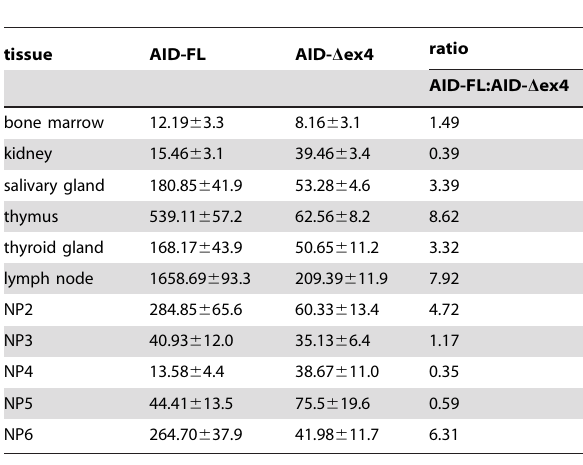
Table 1. Comparative analysis of AID-FL and AID- D ex4 mRNA